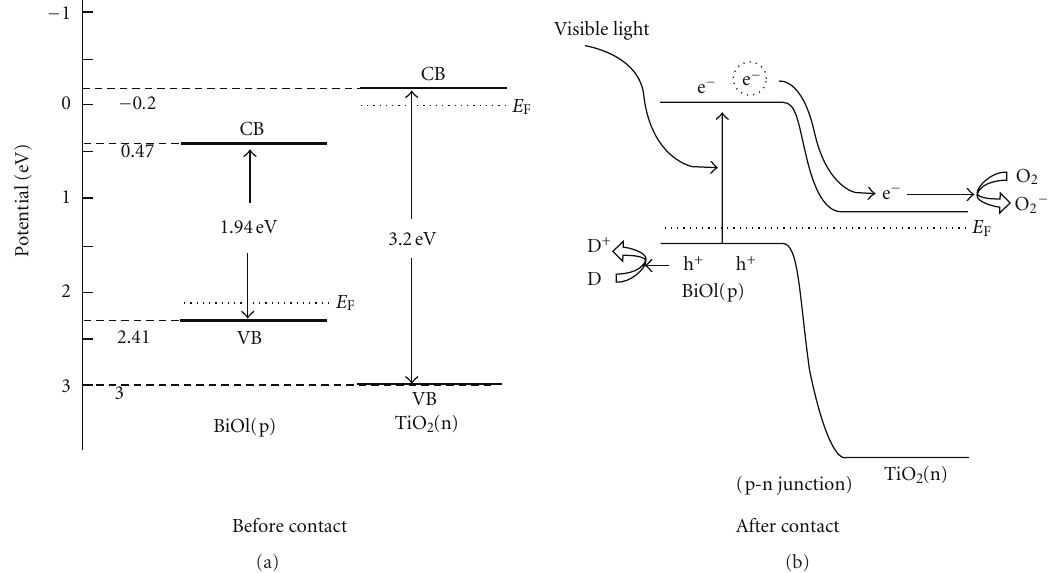
Figure 7: Schematic diagrams for (a) energy bands of p-BiOI and n -TiO 2 before contact and (b) the formation of a p-n junction and its energy band diagram at equilibrium and transfer of photoinduced electrons from p-BiOI to n -TiO 2 under visible-light irradiation [56].